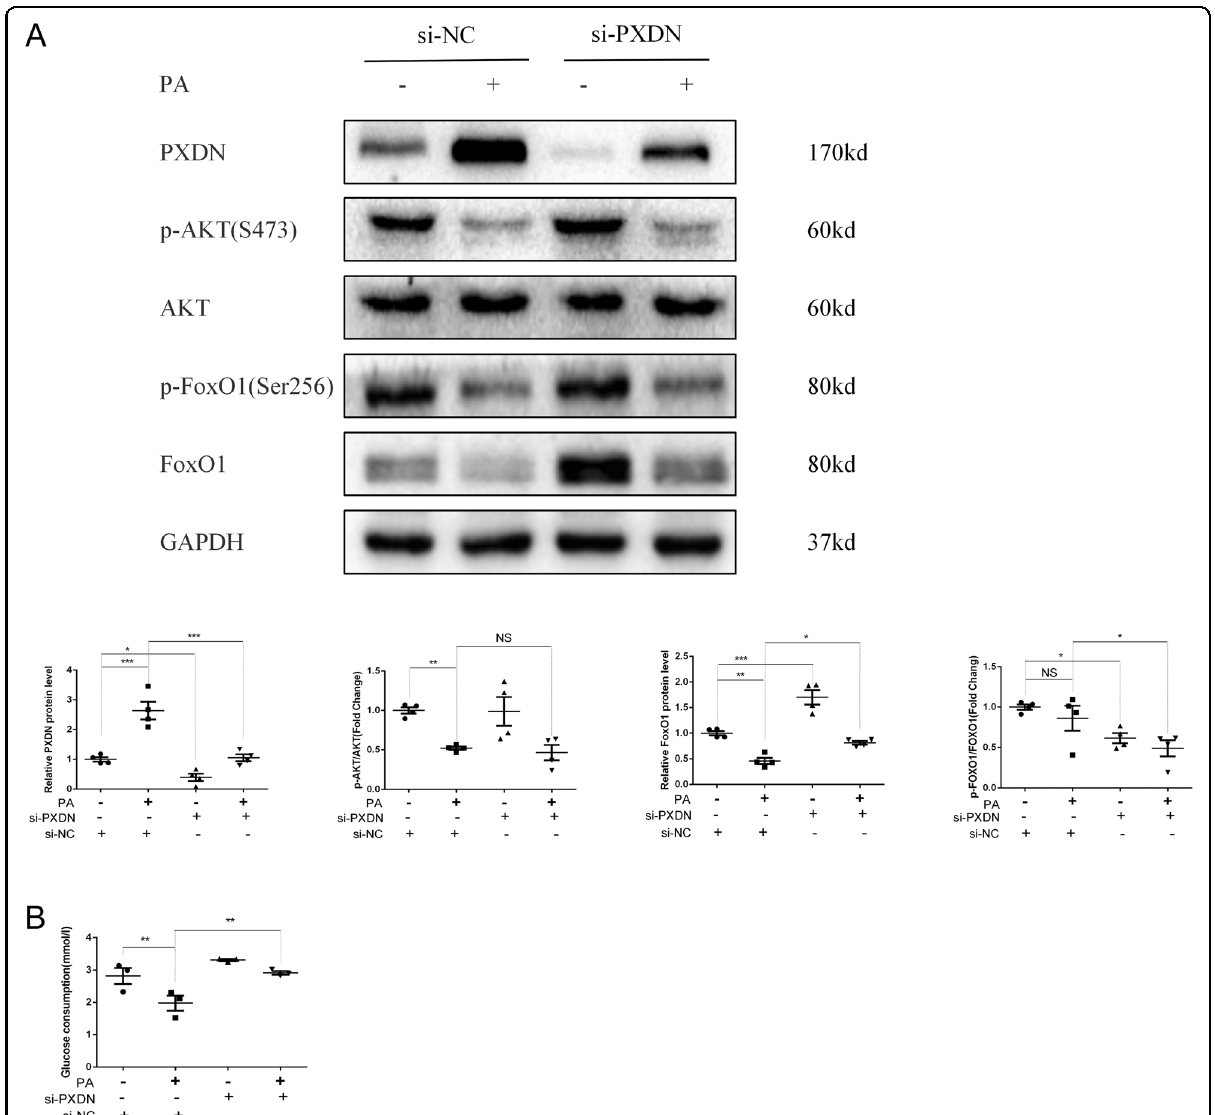
Fig. 3 PXDN silence promotes the expression and activity of forkhead box-1 (FoxO1). A H9C2 cells were treated with 50 μ M si-negative control (NC) or si-PXDN in serum-free medium for 24 h, and treated with 400 μ M palmitate acid (PA) or bovine serum albumin (BSA) for another 24 h. p-AKT, AKT, p-FoxO1 and FoxO1 levels were detected by western blot and quantitative analyses were shown below ( n = 4). B H9C2 cells were treated with si-NC or si-PXDN in the absence or presence of PA; glucose consumption was determined ( n = 3). Data were presented as mean ± SEM. One-way ANOVA test was used. NS referred to no signi fi cance. * P < 0.05, ** P < 0.01, *** P <